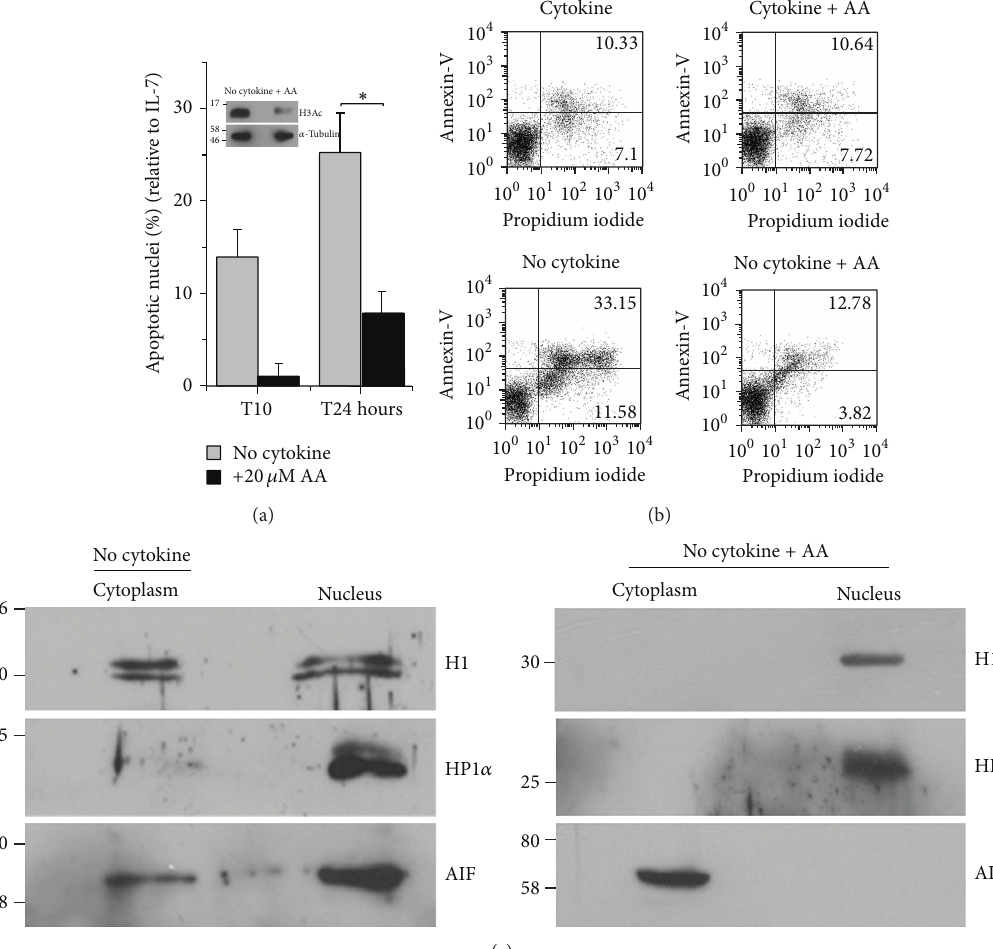
Figure 5: Acetylation dependence of the sub-cellular localization of H1.2 and apoptosis in T-effectors. (a) Apoptotic nuclear damage in T- effectors cultured without cytokine IL-7 (20 ng/ml) and with or without anacardic acid (AA) (20 𝜇 M) for indicated time points. The graph shows the mean ± SD from three experiments. Inset: immunoblot for acetylated H3 (H3Ac) and 𝛼 -tubulin in T-effectors cultured without cytokine (for 6 hours) in the presence or absence of AA. (b) T-effectors cultured for 18 hours in the indicated conditions were stained with propidium iodide ( 𝑥 -axis) and Annexin-V ( 𝑦 -axis) analyzed by flow cytometry. Values in the upper right quadrant, in each plot, indicate dead cells. (c) 10 × 10 6 T-effectors were cultured without cytokine IL-7 (20 ng/ml) and with or without AA (20 𝜇 M) for 6 hours. Immunoblots of nuclear and cytoplasmic fractions were probed for H1 or H1.2, HP1 𝛼 , and AIF. Data shown is representative of three independent